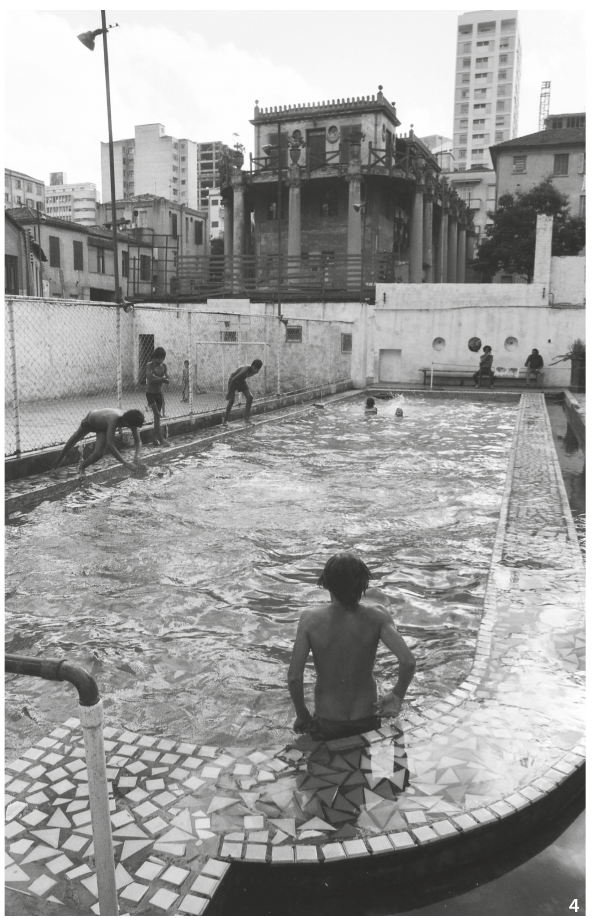
Figure 4 The club pool c. 1970 (Source: Benedito Toledo, date un- known).